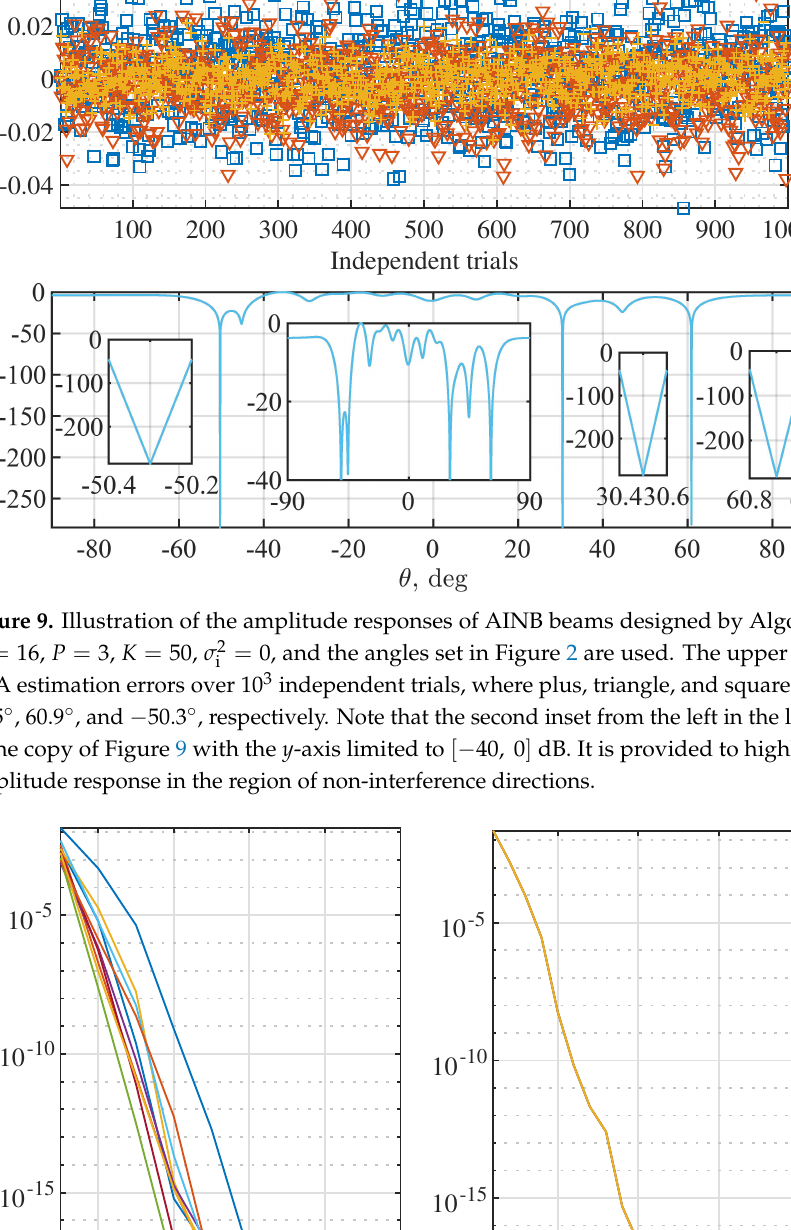
Figure 10. Convergence curves of performing Algorithm 1, where N = 16, σ 2 figures ( a , b ) are for the AINB designs in Figures 7 and 9, respectively. Among all the independent trials performed for the figures, 10 trials are randomly selected with their convergence curves presented